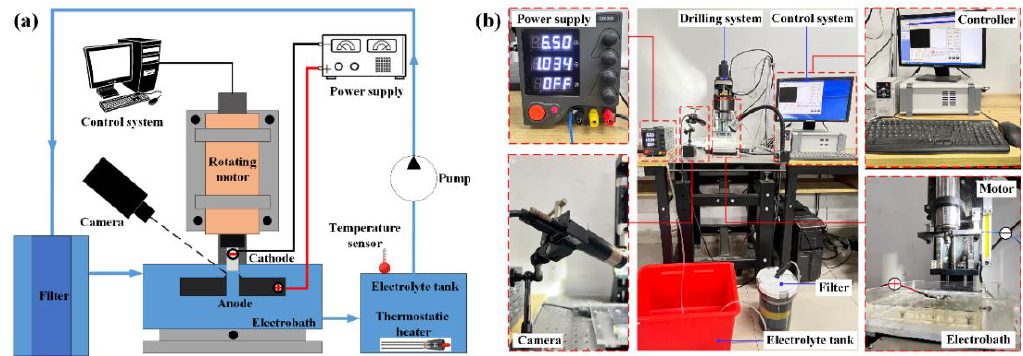
Figure 13. Comparison of MD-ECD machining effects: ( a ) Effect of machining voltage;( b ) Effect of initial machining gap; ( c ) Effect of electrolyte concentration; ( d ) Effect of electrode radius.